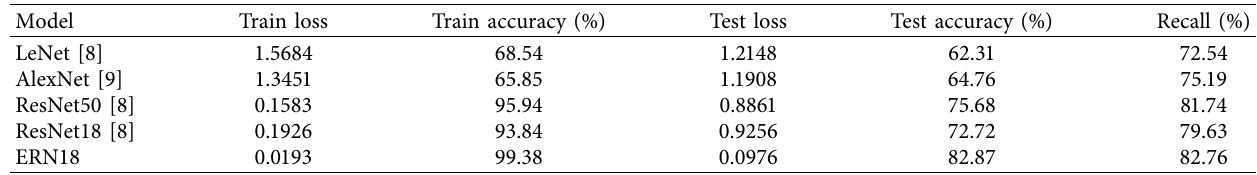
Figure 13: Partial results of test set data classified as dark gray fine sandstone. Table 1: Training and testing accuracy table for each